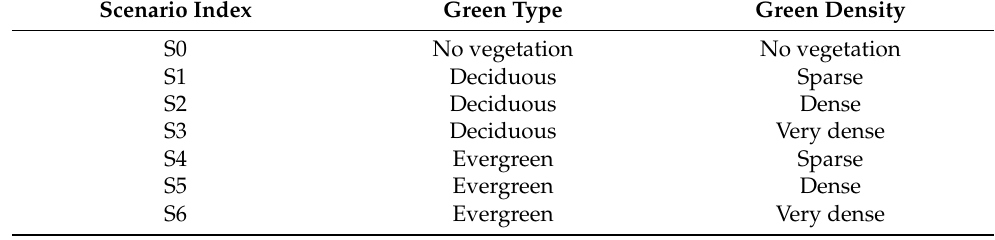
Figure 8. The UTCI level range of scenarios during simulation hours in very deep street canyons (indexed as C).